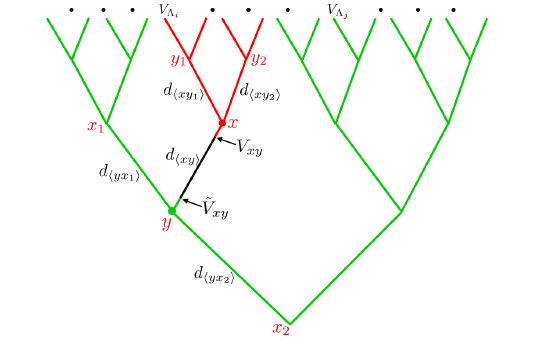
generically deviate i